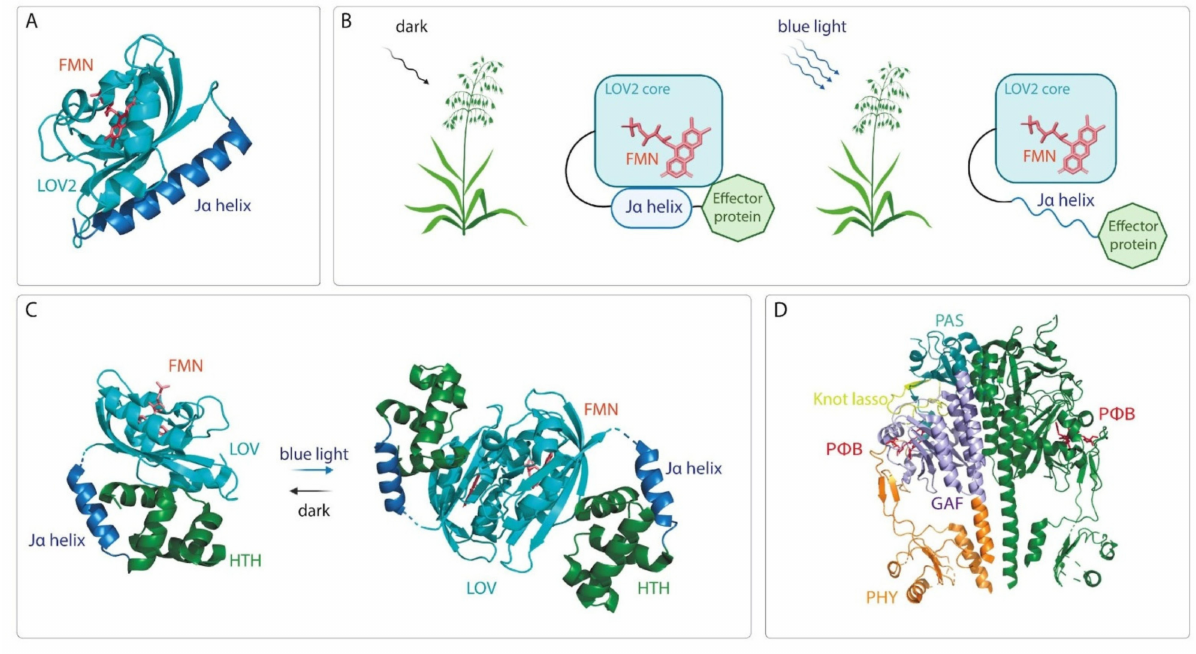
Figure 2. Domain structure and conformational changes of photoreceptors upon absorption of light. ( A ) Shown is the crystal structure of the LOV2 domain of A . sativa phototropin 1 (PDB ID 2V0U). The LOV2 domain is presented as ribbons (cyan) and the flavin chromophore as a stick model (red). ( B ) Schematic structure of the LOV2 domain from A . sativa fused with effector protein in darkness and under blue light. In dark, J α helix docks onto the LOV2 core; under blue light it undocks, making the effector protein available for protein-protein interaction. ( C ) Homodimerization of the LOV domain containing protein EL222 from E . litoralis under blue light. The protein structure is presented as ribbons (cyan, blue, green) and the flavin chromophore is shown as a stick model (red). The crystal structure of the LOV domain from E . litoralis (PDB ID 3P7N) was used for visualization. HTH – DNA binding helix–turn–helix domain. ( D ) Typical domain structure of the photosensory module of the plant phytochromes. The PAS, GAF, and PHY domains are shown in cyan, purple, and orange ribbons, respectively; the C-terminal output module is not shown. The chromophore (P Φ B) is shown as a stick model (red). The crystal structure of A . thaliana PhyB photosensory module (PDB ID 4OUR) was used for